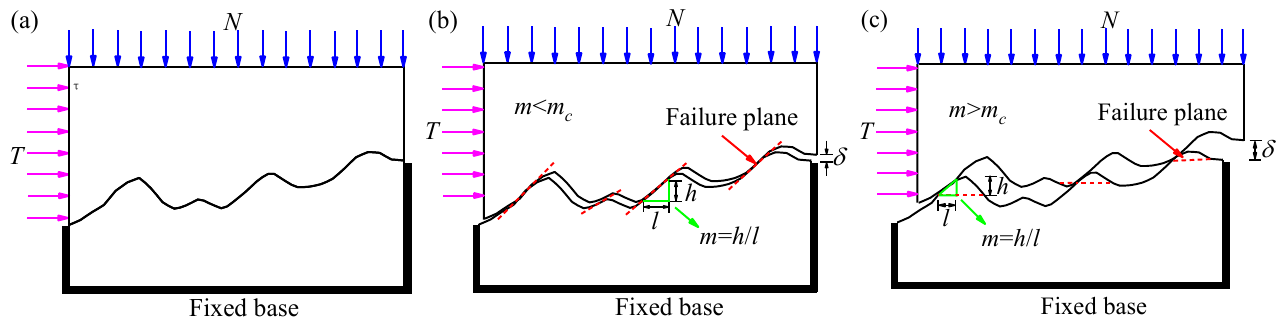
Figure 12. Failure modes of rock joints during direct shear test. ( a ) Joint matching; ( b ) Dilatancy failure; ( c ) Fracture failure. The aspect ratio of the local convex area is m = h / l , and the dilatancy is δ .